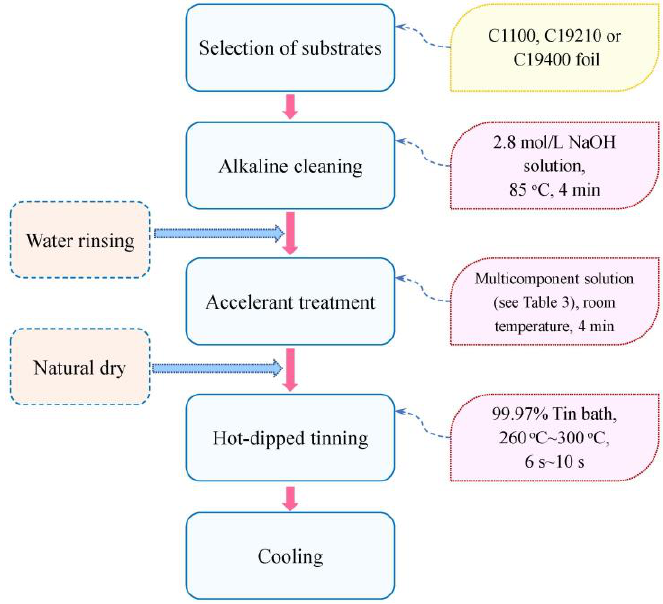
Figure 11. Optimal hot-dipped tinning process routine for copper lead frames used in integrated circuit plates.